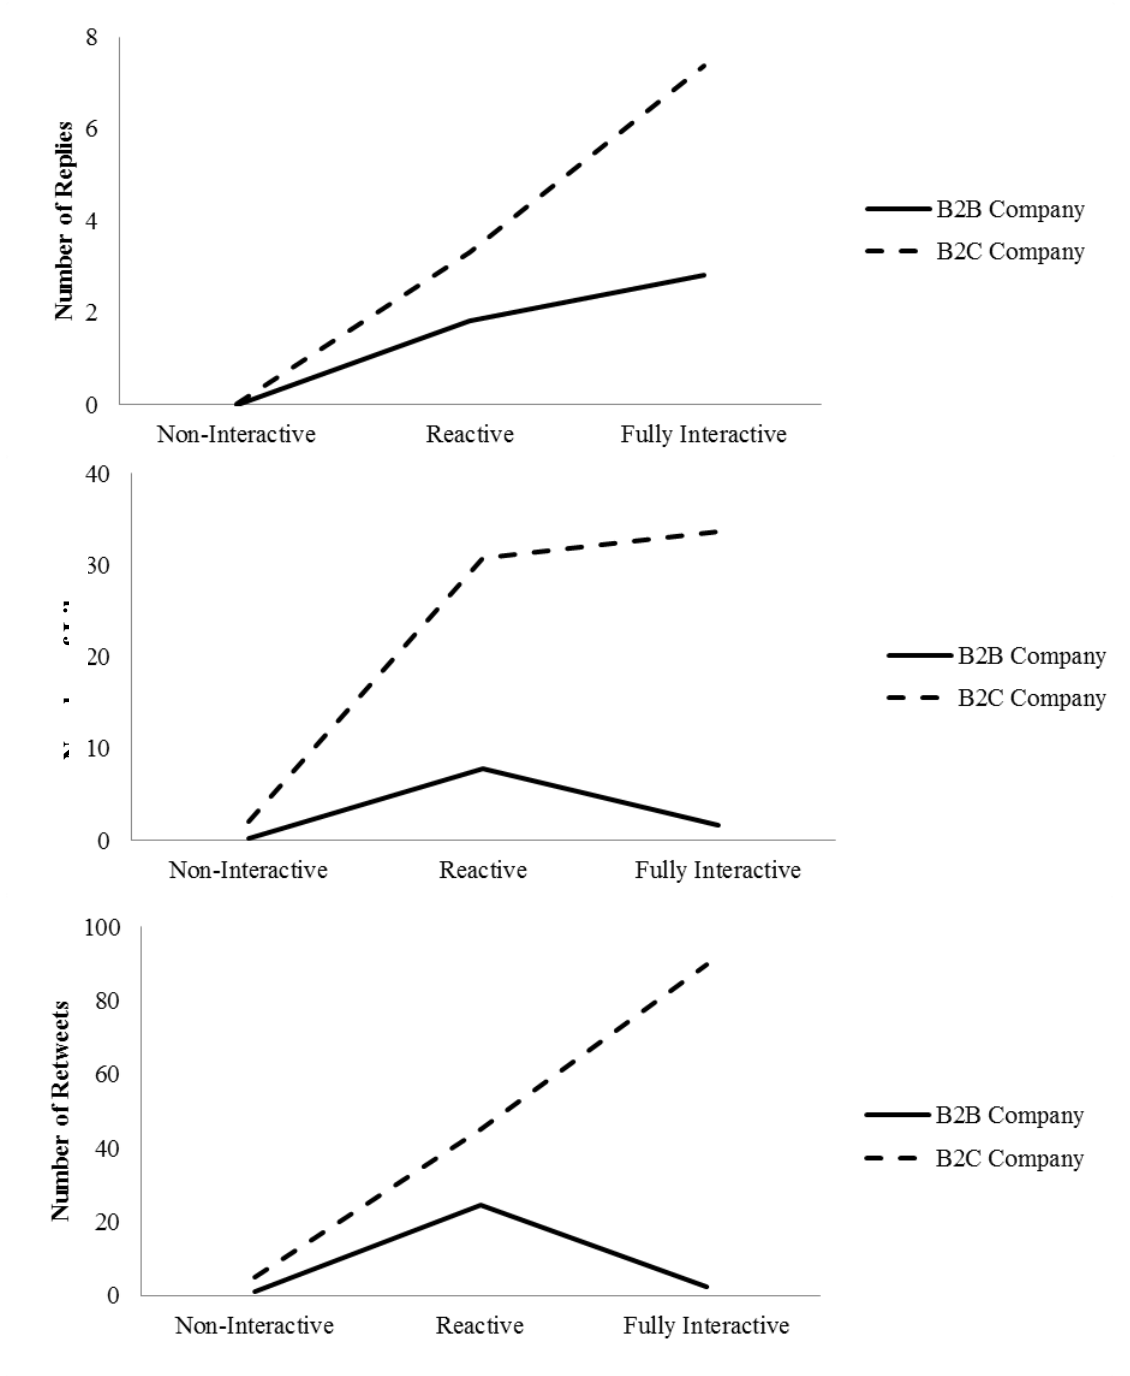
Fig. 1. Interaction between interactivity and company type on a) number of replies, b) number of retweets, and c) number of